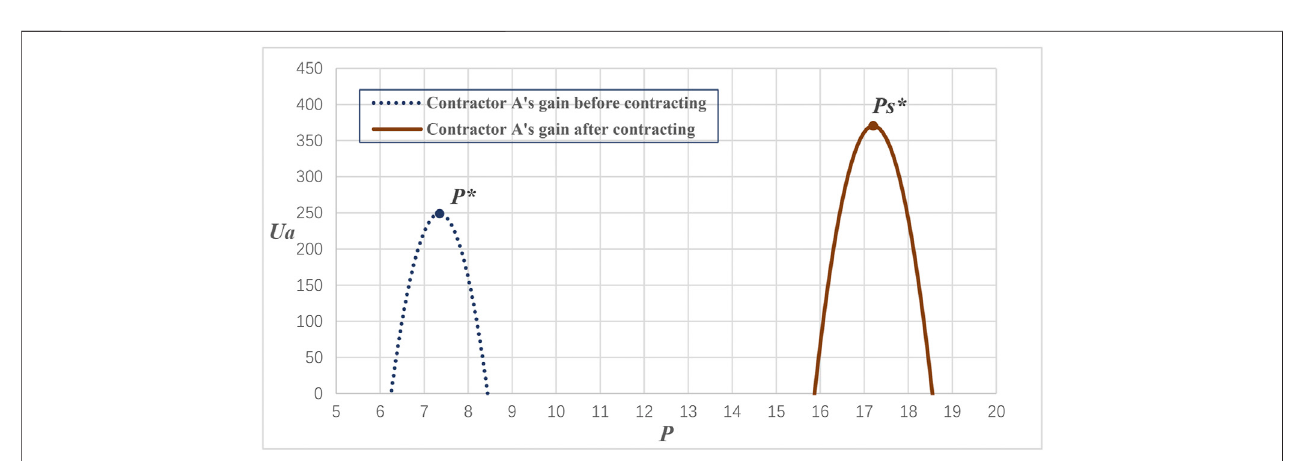
FIGURE 3 | The critical contractor ’ s gain function before and after contracting in Scenario